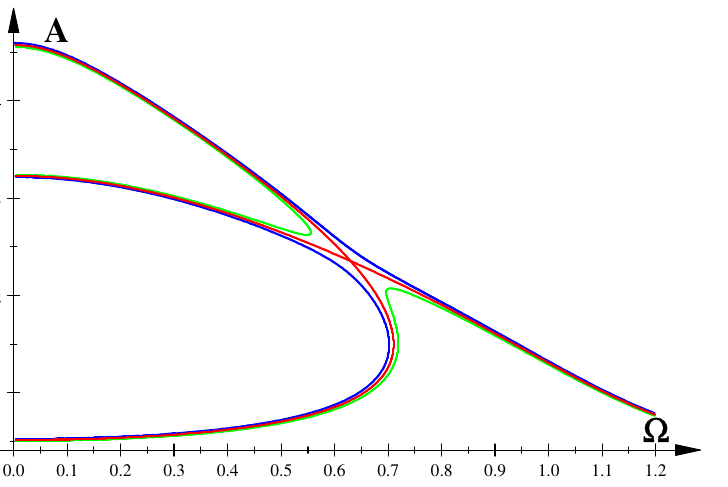
Figure 3. The bifurcation sets: M 1 (Duffing)—dashed, M 7 —green (physical self-intersections), blue (unphysical self-intersections), magenta (unphysical isolated points).